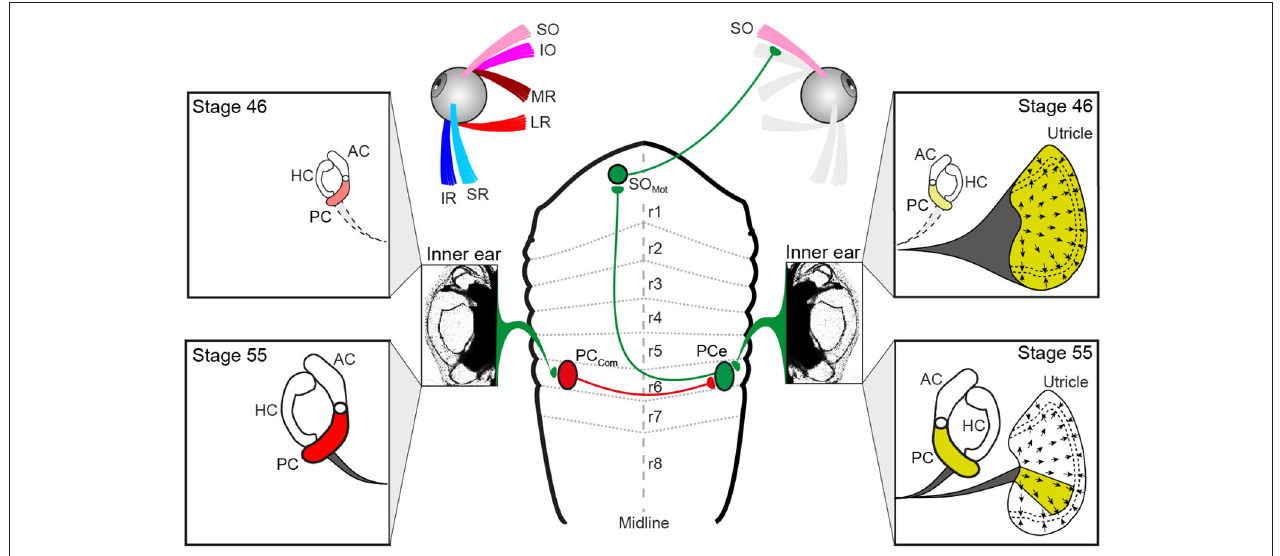
FIGURE 6 | Schematics depicting the hindbrain connectivity of vestibular endorgans and the SO eye muscle along with the developmental changes in utricular and semicircular canal contributions during the developmental tuning of the SO nerve response vector. At stage 46, SO nerve responses derive from the entire utricle (yellow labeling on the right), whereas at stage 55, SO nerve responses derive from a utricular sector that aligns with the PC on the same side; the spatial restriction of the response vector in the direction perpendicular to the SO muscle derives from the contralateral PC (red labeling on the left) and is potentially mediated by midline crossing inhibitory pathways. AC, PC, HC, anterior, posterior vertical, horizontal semicircular canal; IO, inferior oblique; IR, inferior rectus; LR, lateral rectus; MR, medial rectus; PCe, excitatory PC neuron; r1-8, rhombomere 1-8; SO, superior oblique; SR, superior rectus, PC com , posterior canal commissural neuron; SO Mot , superior oblique